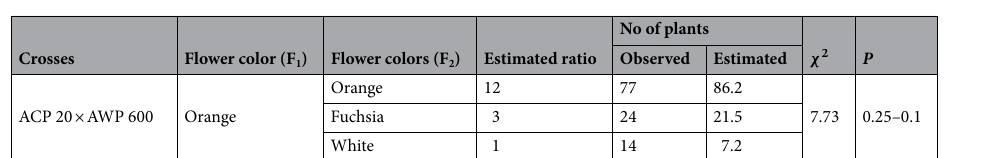
Figure 1. Orange ( a ), fuchsia ( b ) and white ( c ) flower colors in F 2 population derived from interspecific crosses P. sativum (ACP 20) × P. fulvum (AWP 600). Super early progeny for fresh seeds ( d ), Super early progeny for vegetables ( e ), View of the lines ( f , g ).